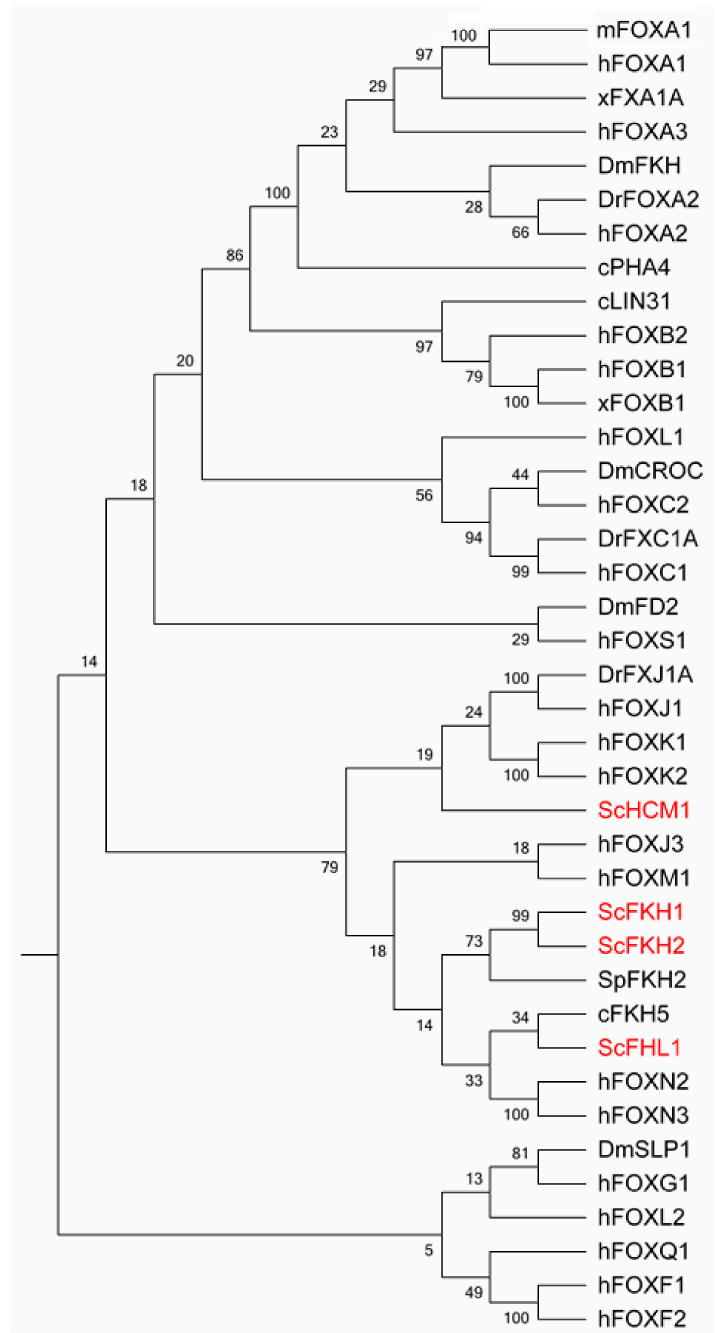
Figure 1. Phylogeny tree of representative forkhead box (Fox) transcription factors (TFs) from the primary model eukaryotic organisms based on the amino acid sequence of the forkhead domain. The evolutionary history was inferred using the neighbor joining method in MEGA7. The bootstrap consensus tree inferred from 100 replicates was taken to represent the evolutionary history of the taxa analyzed. Branches corresponding to partitions reproduced in less than 50% bootstrap replicates are collapsed. The percentage of replicate trees in which the associated taxa clustered together in the bootstrap test (100 replicates) are shown next to the branches. The evolutionary distances were computed using the Poisson correction method and are in the units of the number of amino acid substitutions per site [3]. Sc: Saccharomyces cerevisiae , Sp: Schizo s accharomyces pombe , c: Caenorhabditis elegans , Dr: Danio rerio , Dm: Drosophila melanogaster ,m: Mus musculus , x: Xenopus Laevis , h: Homo sapien